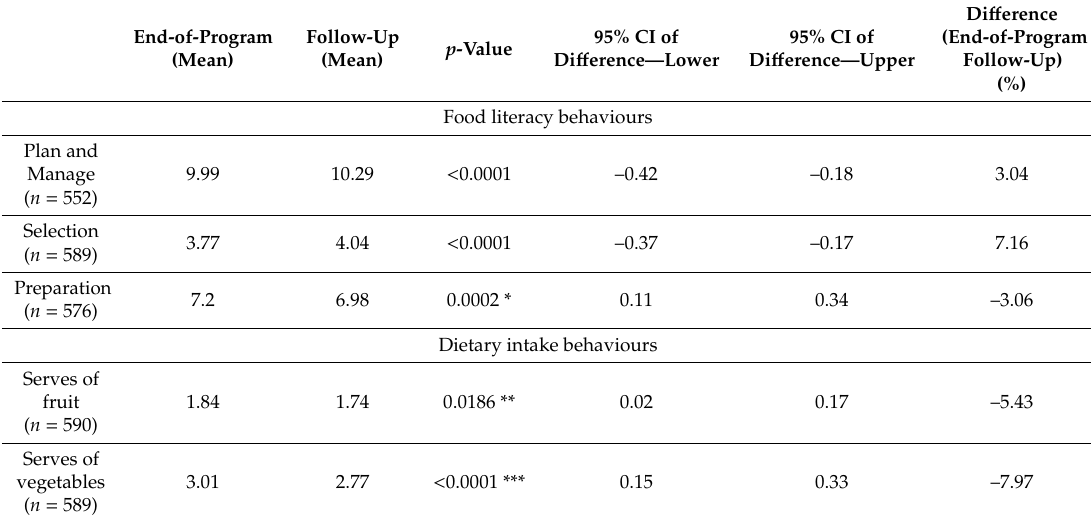
Table 2. Comparing end-of-program and follow-up questionnaire scores regarding the three food literacy behaviour domains and changes in self-reported dietary intake of fruit and